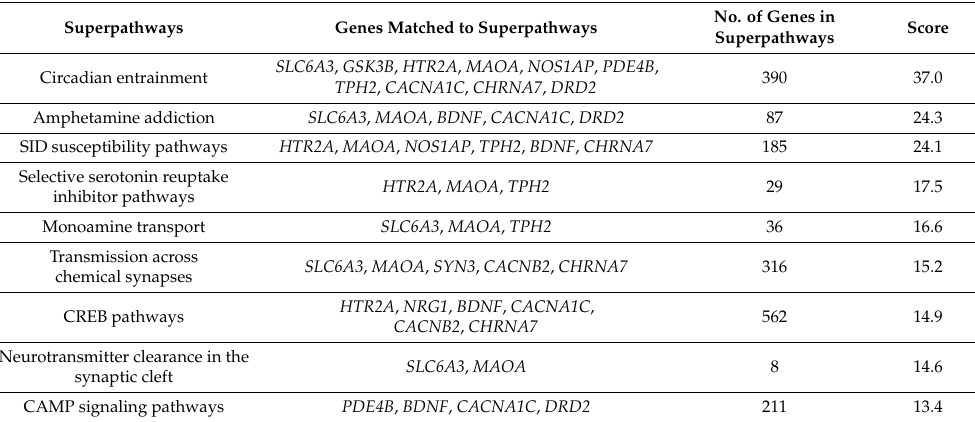
Table 3. GeneAnalytics program mapping of superpathways with high match scores for 23 overlapping genes for autism spectrum disorder, bipolar disorder and schizophrenia.